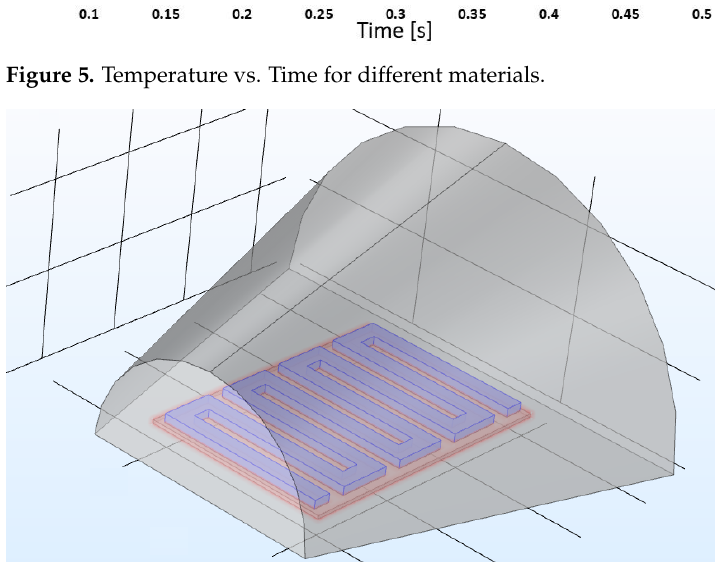
Figure 6. Final sensor design.